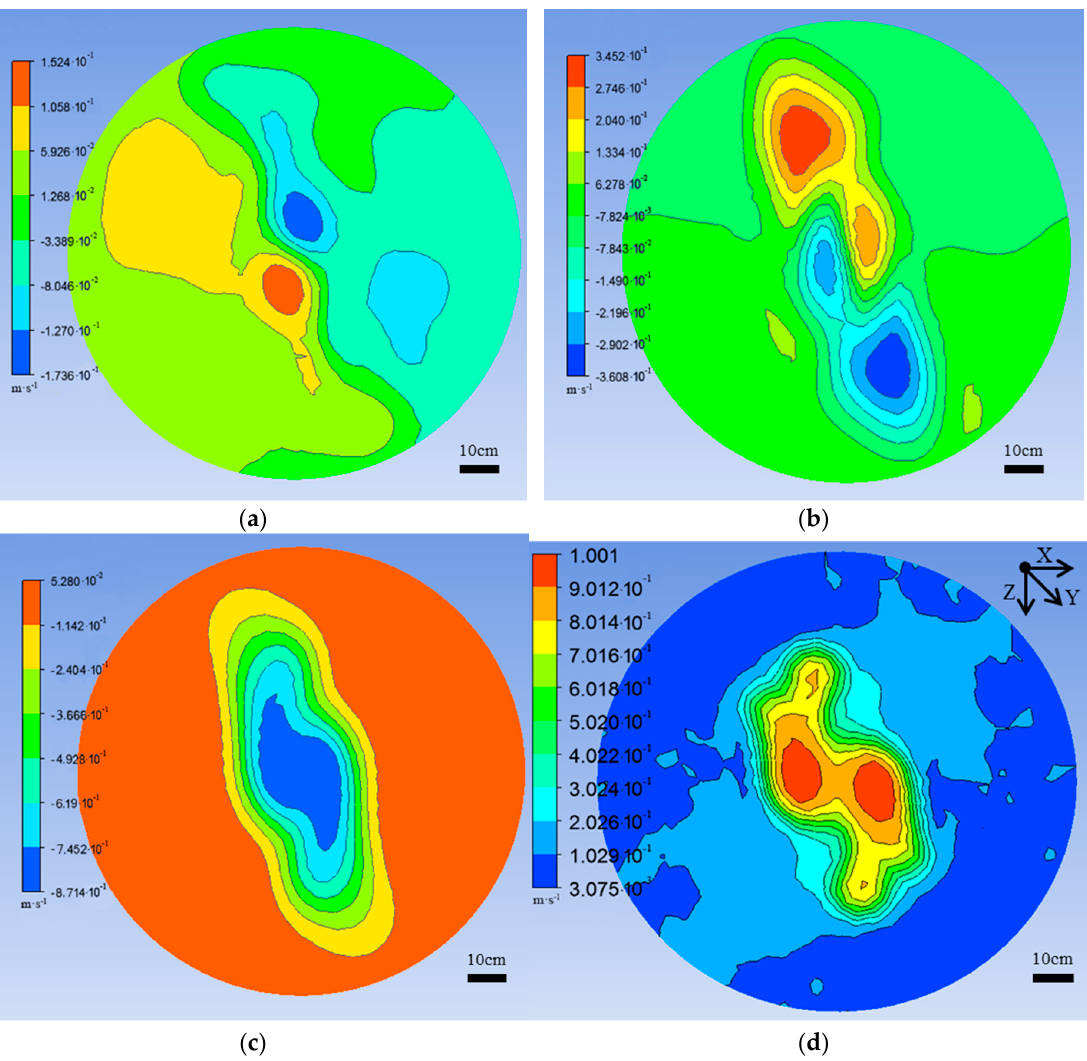
Figure 5. Ground-velocity nephogram distribution results. ( a ) X-axial velocity distribution nephogram; ( b ) Y-axial velocity distribution nephogram; ( c ) Z-axial velocity distribution nephogram; ( d ) combined velocity distribution nephogram.